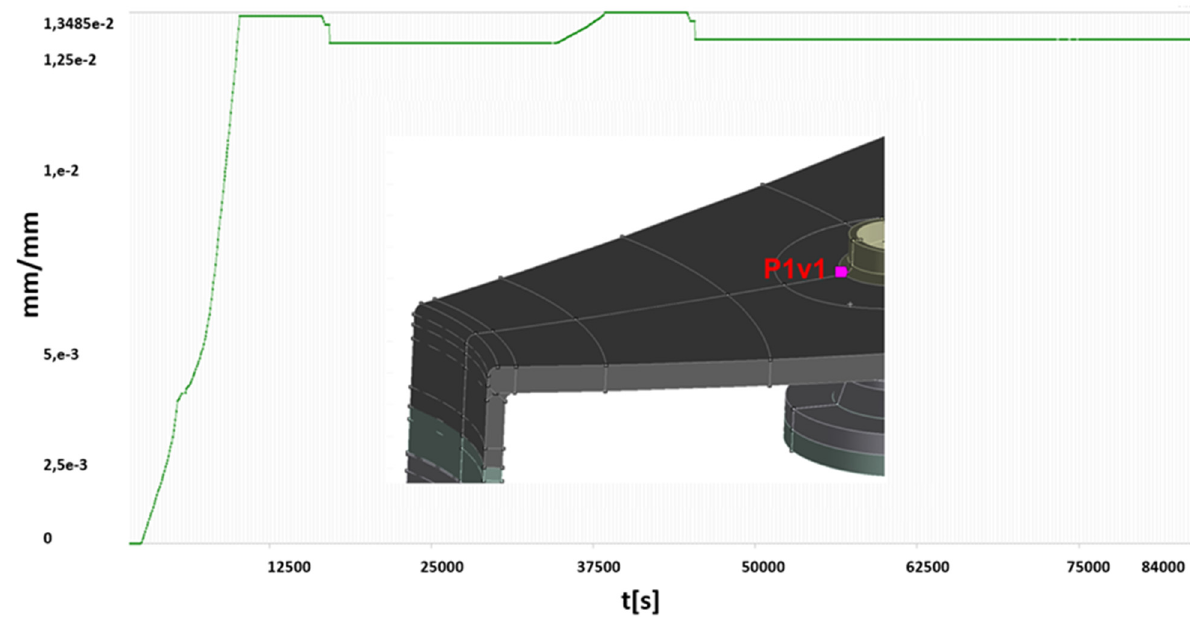
Figure 15. Generalized plastic strain for the entire loading scheme—point P1v1.